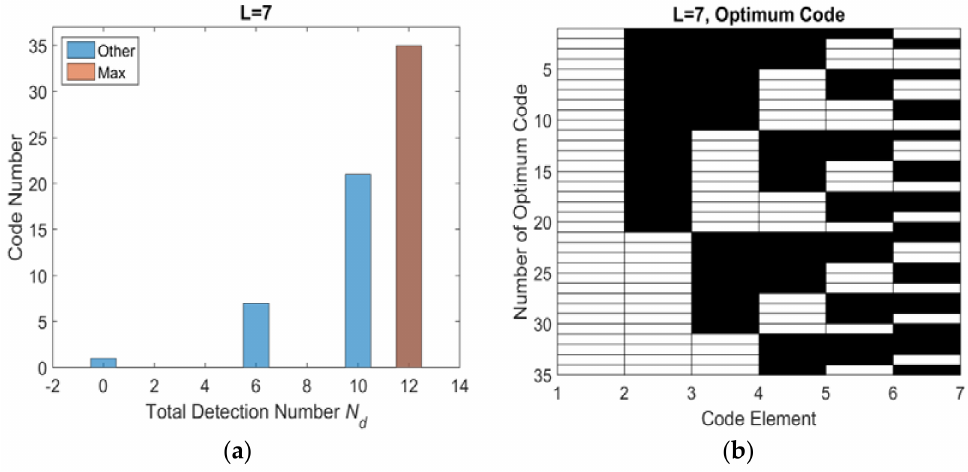
Figure 5. L = 7 optimum codes and corresponding N d ( a ) histogram distribution of N d ( b ) optimum